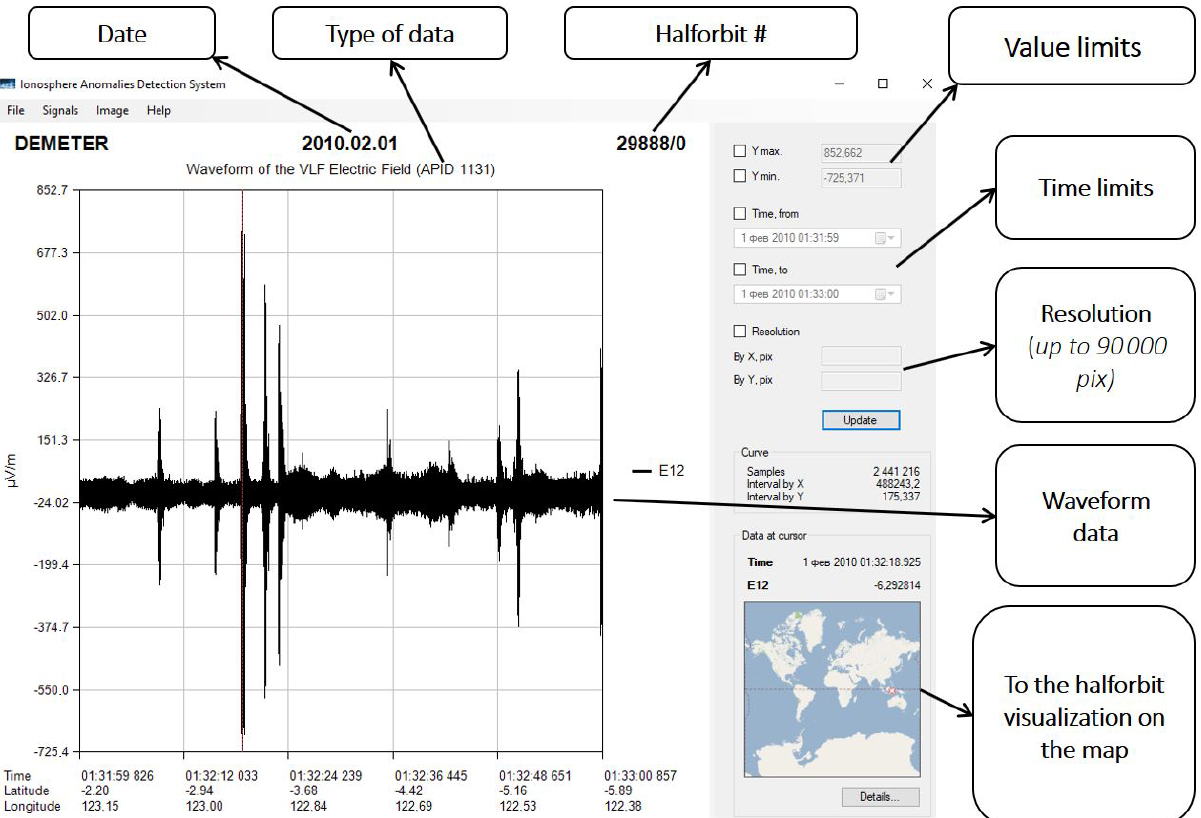
Figure 1. The screenshot of the main window of the DIA package with an example of graph of electric field in VLF